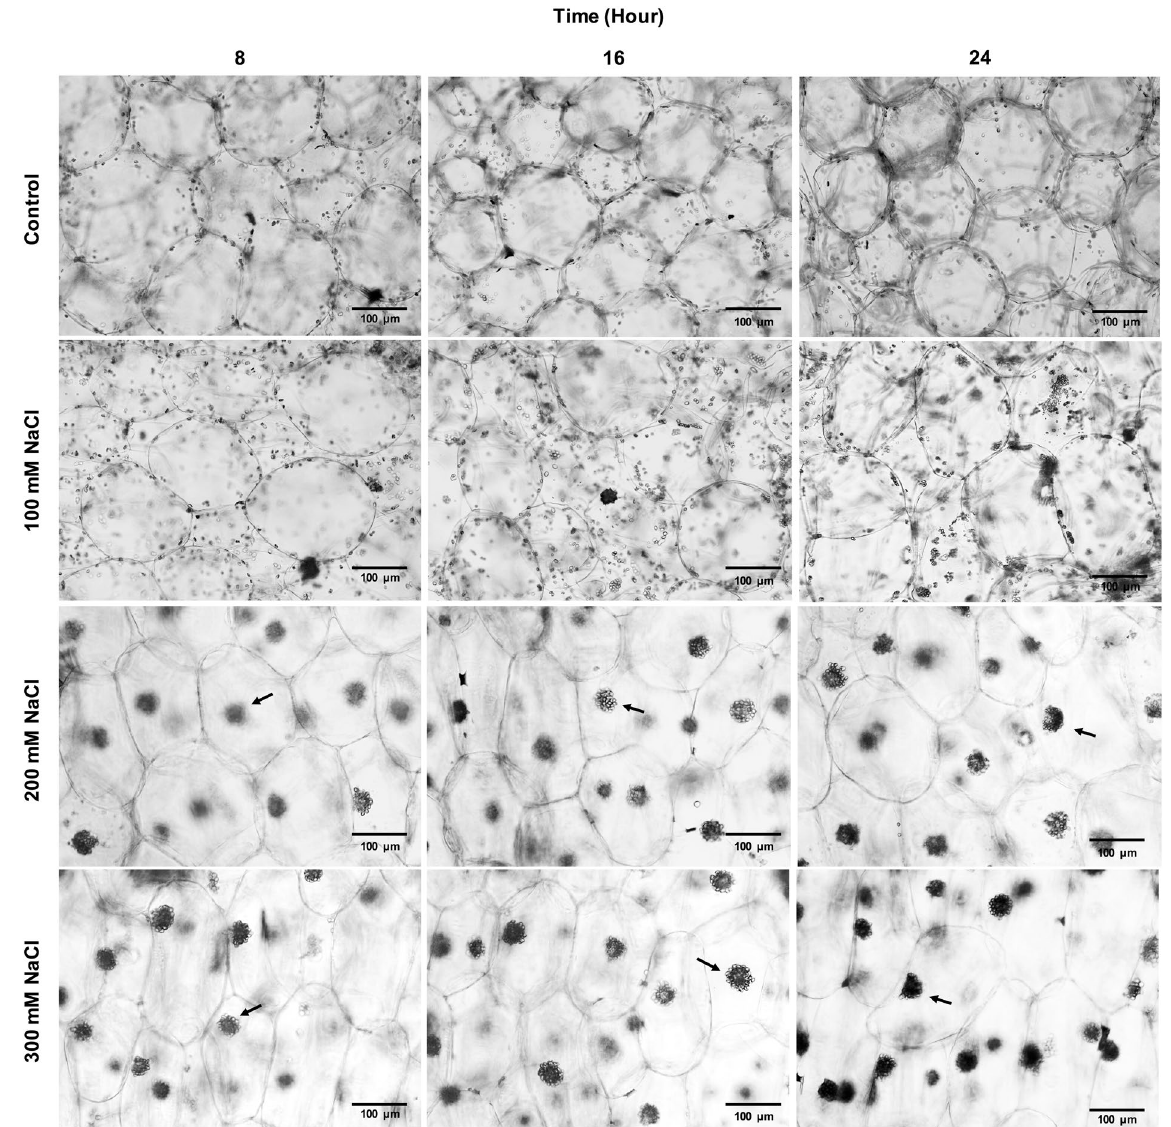
Figure 3. The chloroplast arrangement in chlorenchyma cells from Opuntia streptacantha under salt treatments. Representative images of O . streptacantha cells and their chloroplast are shown in each panel. Cladode segments were cut, and after they were incubated in 0, 100, 200, and 300 mM NaCl under continuous white light (300 µ mol m − 2 s − 1 ) for 8, 16, and 24 h. Transverse sections from cladode were observed with a light microscope. The black arrowheads indicate chloroplast clusters. Scale bar corresponds to 100 μ